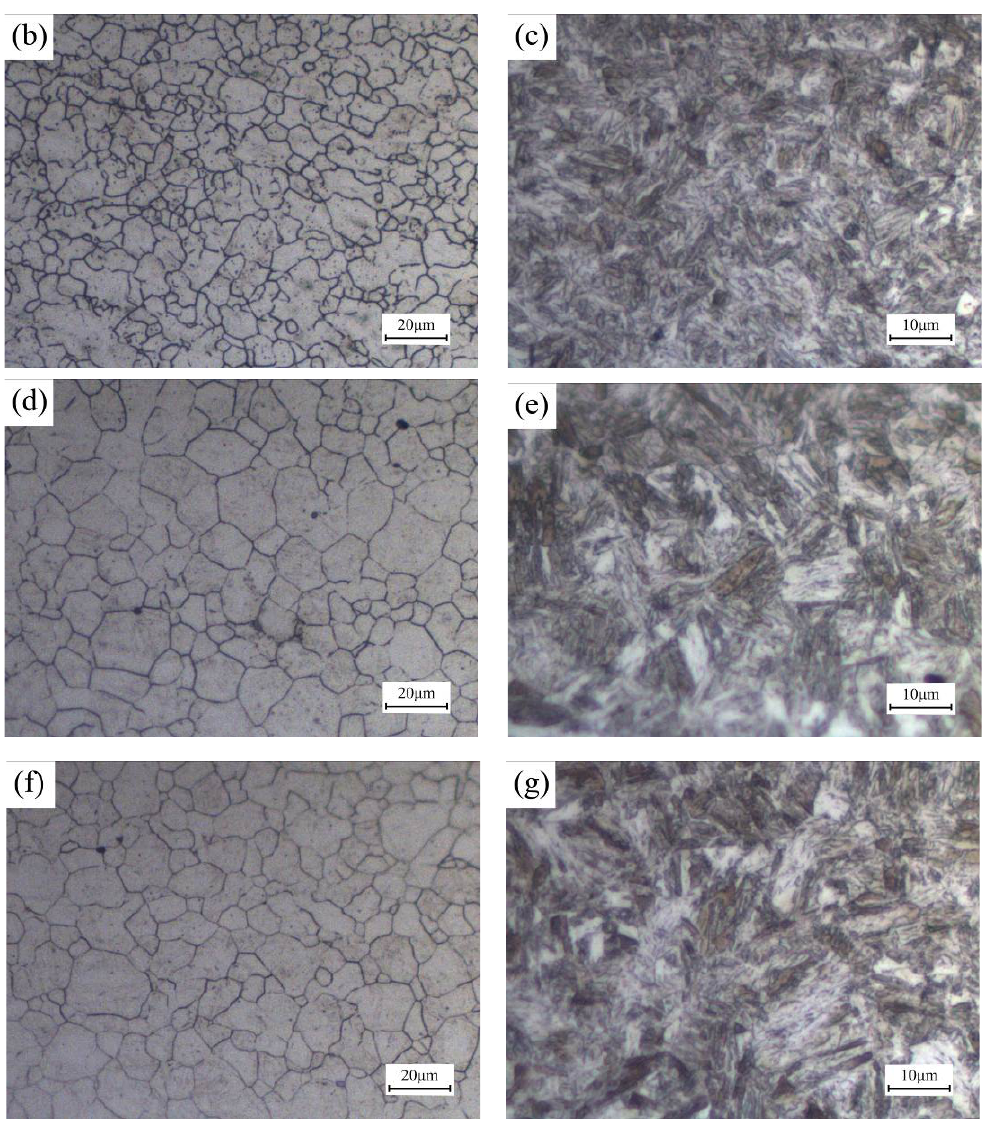
Figure 8. Grain morphology of quenched weld joint ( a ) cross-section; ( b ) FZ; ( d ) original HAZ; ( f ) BM, and the metallographic structure of ( c ); FZ ( e ); original HAZ; ( g ) BM.